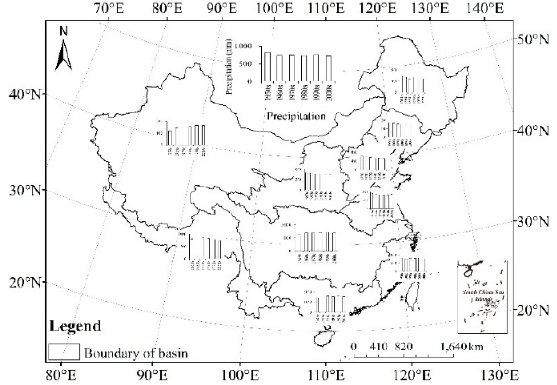
Figure 5. Interdecadal rainfall changes in the main basins in China during the